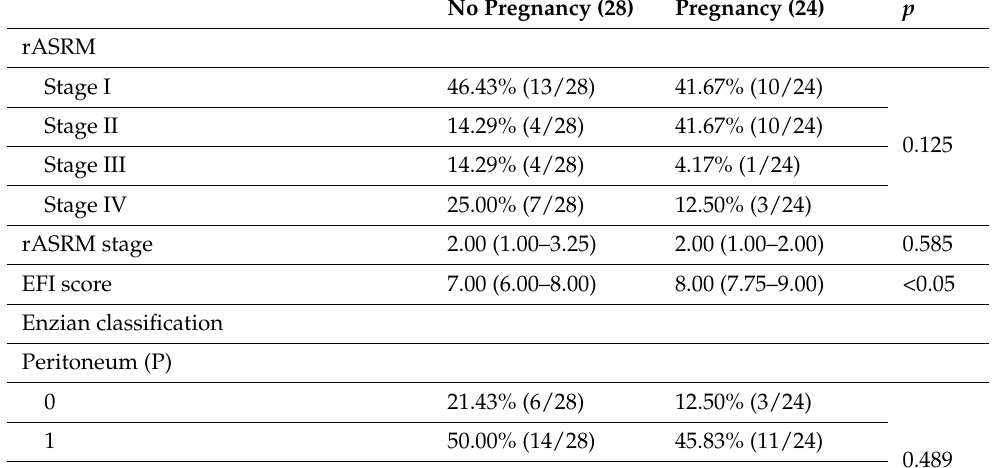
Table 2. Pregnancies after ART (assisted reproductive technology): score subdivided in accordance with the pregnancy